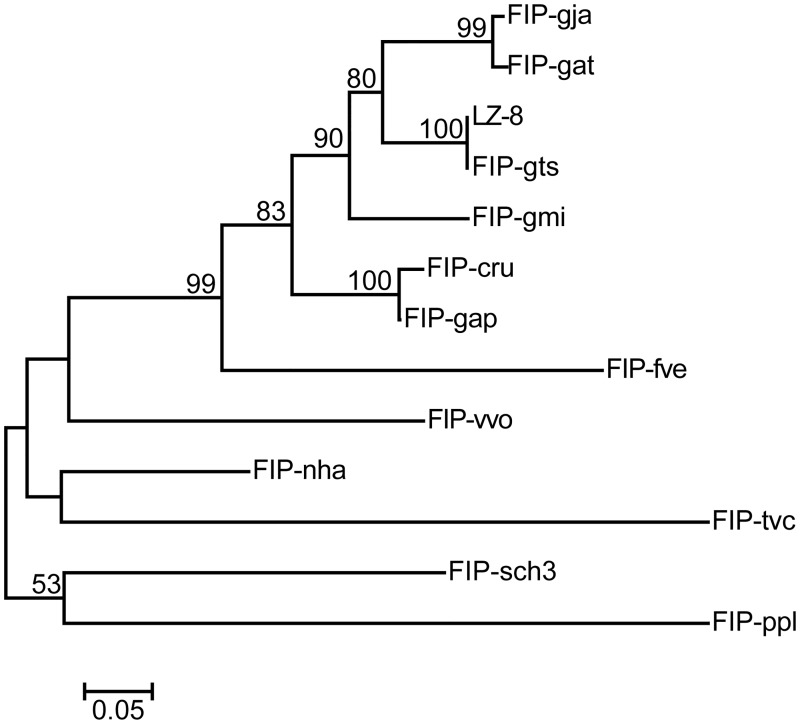
Evolutionary relationships of FIPs.The evolutionary history was inferred using the Neighbour-Joining method [21]. The optimal tree with a sum of branch length = 2.61058163 is shown. The percentage of replicate trees in which the associated FIPs clustered together in the bootstrap test (1000 replicates) are shown next to the branches [22]. The tree is drawn to scale with branch lengths in the same units as those of the evolutionary distances that were used to infer the phylogenetic tree. The evolutionary distances were computed using the JTT matrix-based method [23] and have units of the number of amino acid substitutions per site. The analysis involved 13 amino acid sequences. All positions containing gaps and missing data were eliminated. There were a total of 110 positions in the final dataset. Evolutionary analyses were conducted in MEGA7.